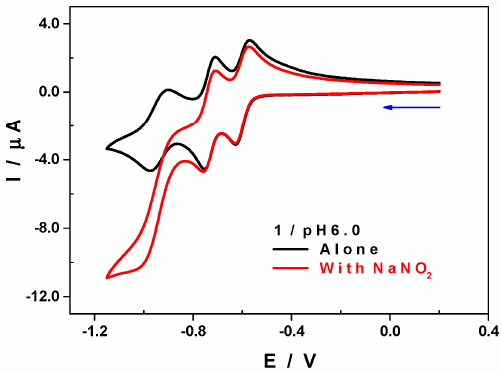
Figure 6. CV of 1 recorded in 1.0 M of LiOAc + HOAc / pH 6.0, in the absence (black) and in the presence (red) of NaNO 2 at a scan rate of 10 mV.s − 1 . Concentrations: [1] = 0.20 mM, [NaNO 2 ] = 10 mM. Working electrode: GC; counter electrode: Pt gauze; reference electrode: SCE.